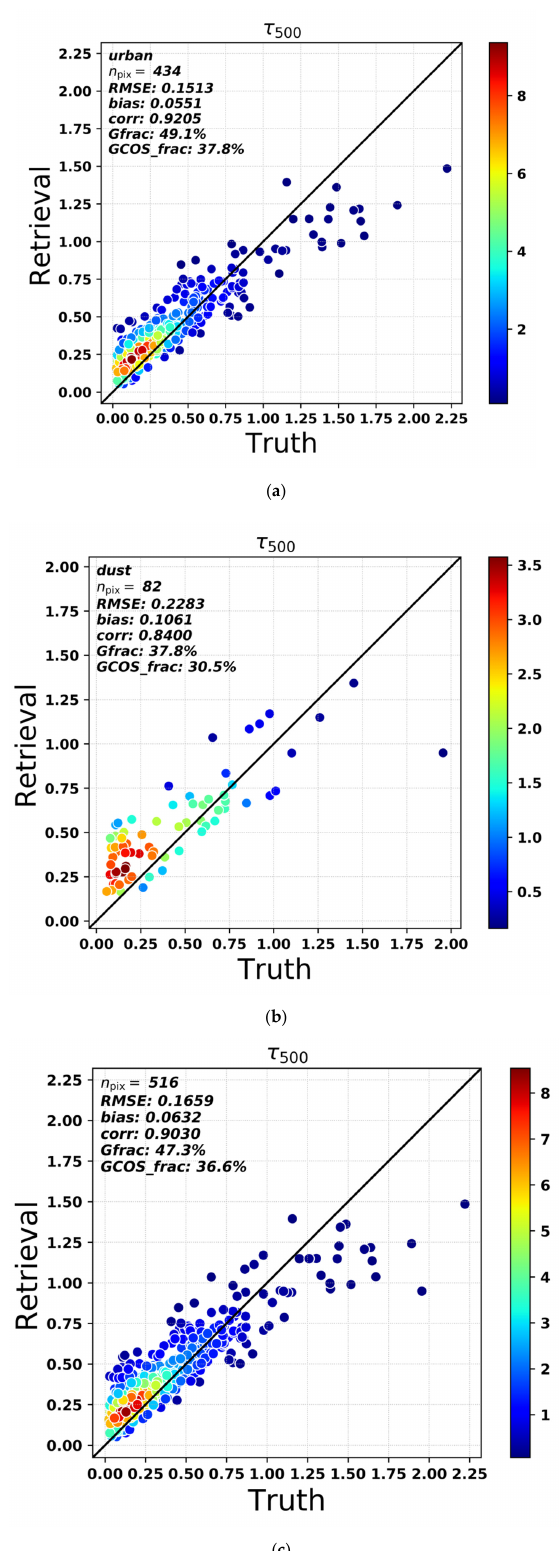
Figure 1. Validation of the AOD at 500 nm retrieved from DPC against AERONET measurements. The validation results for urban stations (FMF ≥ 0.5), dust stations (FMF < 0.5) and all matchups are shown in subplot ( a – c ), respectively. The color of each point represents the density of the point where the point is located. The application to POLDER data of the same algorithm in the same setup resulted in quite similar RMSE values as we obtain for DPC (~0.19 for PARASOL and ~0.166 for DPC, respectively), although it should be noted that the global performance evaluation cannot be compared one ‐ to ‐ one to the regional evaluation here. The Gfrac of DPC AOD within the error envelope of ±(0.05 + 15%) for all matchups is 47.3%, close to that of PARASOL AOD (45.1% at 675 nm) with the GRASP algorithm [54]. Figure 2 shows the probability distribution of the AOD retrieval bias. It can be seen that there is a significant overestimation when AOD < 0.3, but it is not obvious when AOD > 0.3. The AOD retrieval biases in different AOD intervals are calculated and shown in Figure 3. It demonstrates that there is significant overestimation when AOD < 0.2, and significant underestimation when AOD > 1.5. A similar performance was found in AOD retrieval with GRASP algorithm using PARASOL data. Tan et al., 2019 found that the PARASOL/GRASP AOD is overestimated in low aerosol loadings, and underes ‐ timated in heavy aerosol loadings, as validated against AERONET measurements over China [54]. On the other hand, optimization of the algorithms may be possible to im ‐ prove the retrieval capability for moderate aerosol loading.